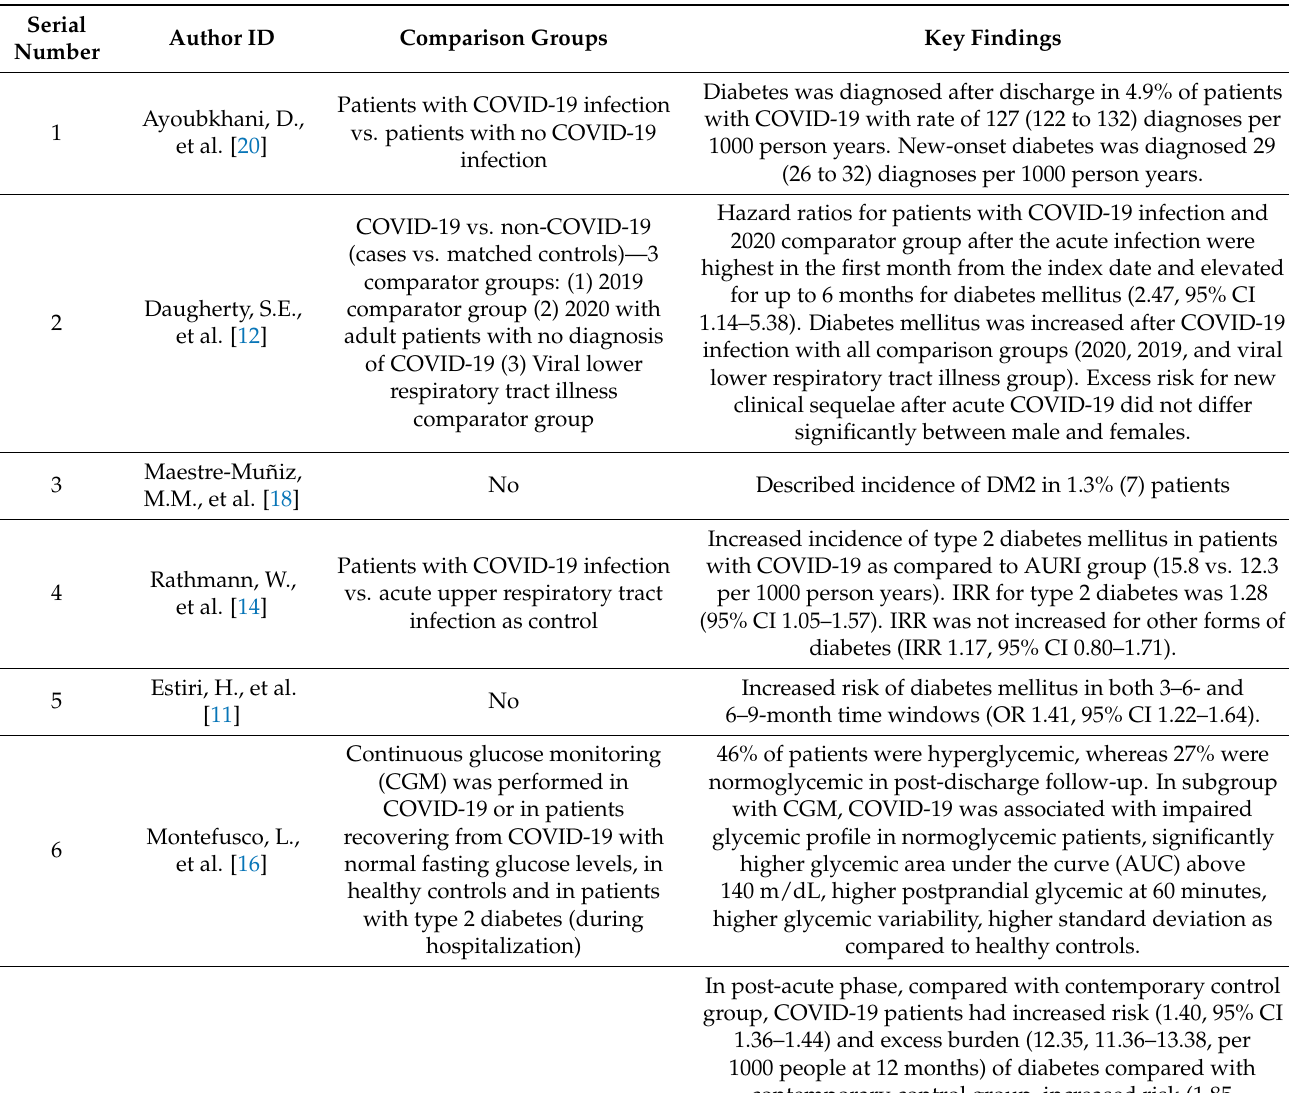
Table 2. Key findings in included